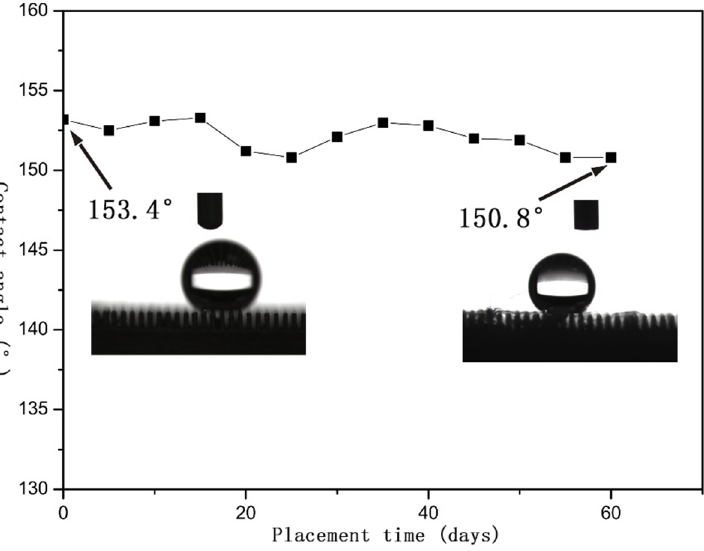
Figure 5. Contact angle of 3D-printed + modified samples placed outdoors for different time.